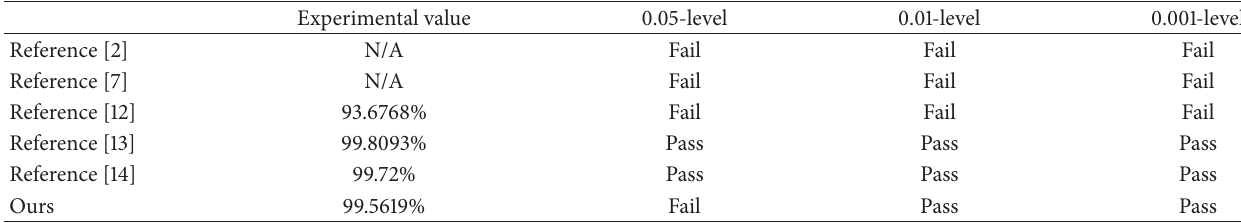
Table 5: NPCR test for the different image encryption algorithms.